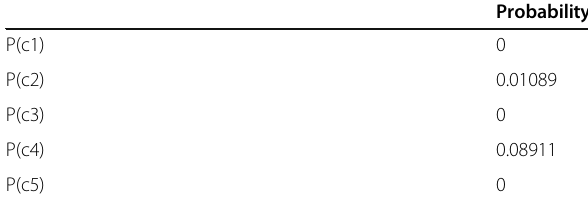
Table 4 The calculation of second predicted point